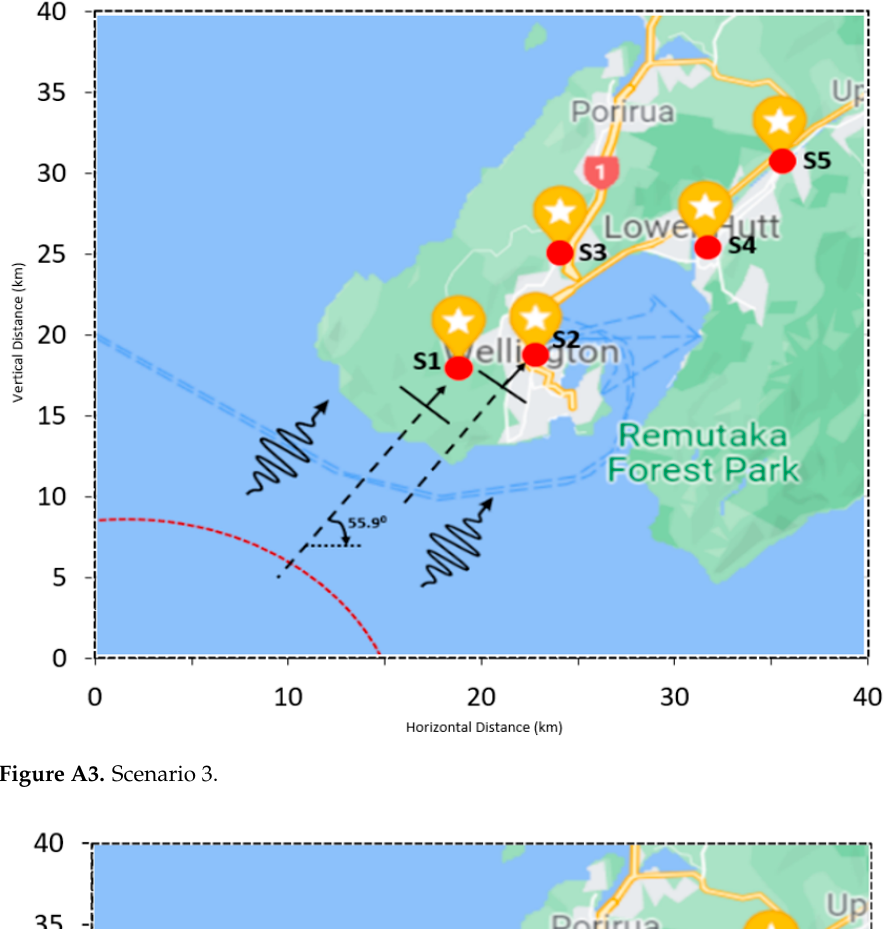
Figure A3. Scenario 3.